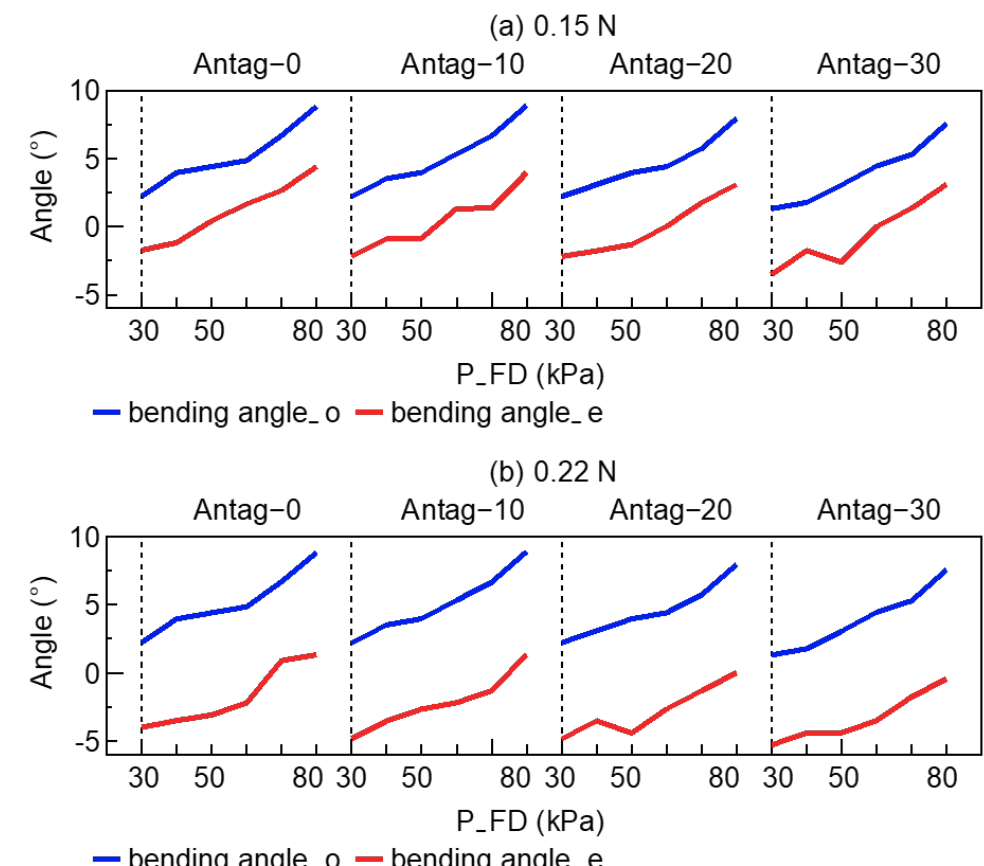
Sensors 2023 , 23 , x FOR PEER REVIEW Figure 8. The bending angle_o and bending angle_e of the soft actuator ( a ) 0.15 N, ( b ) 0.22 N.